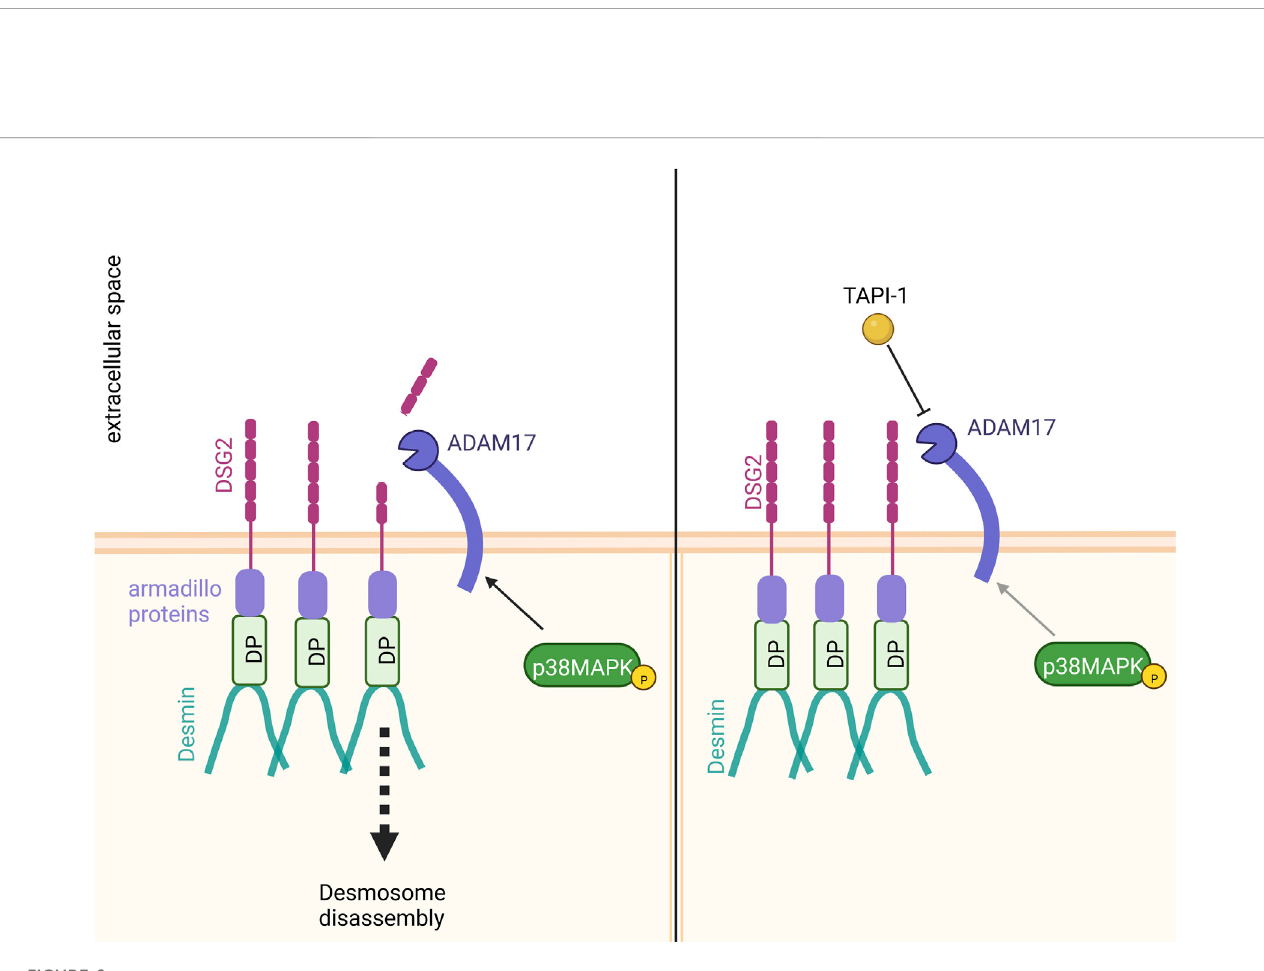
FIGURE 6 Proposed mechanism of action. Inhibition of ADAM17 by TAPI-1 enhanced the localization of DP and DSG2 at the membrane. Since we observed no changes in desmosomal assembly or the desmosomal complex upon inhibition of ADAM17, we hypothesize that the increase in cardiomyocyte cohesion upon inhibition of ADAM17 could result from reduced DSG2 cleavage. In contrast, without ADAM17 inhibition, basal ADAM17 activity leads to DSG2 cleavage with subsequent desmosome disassembly.